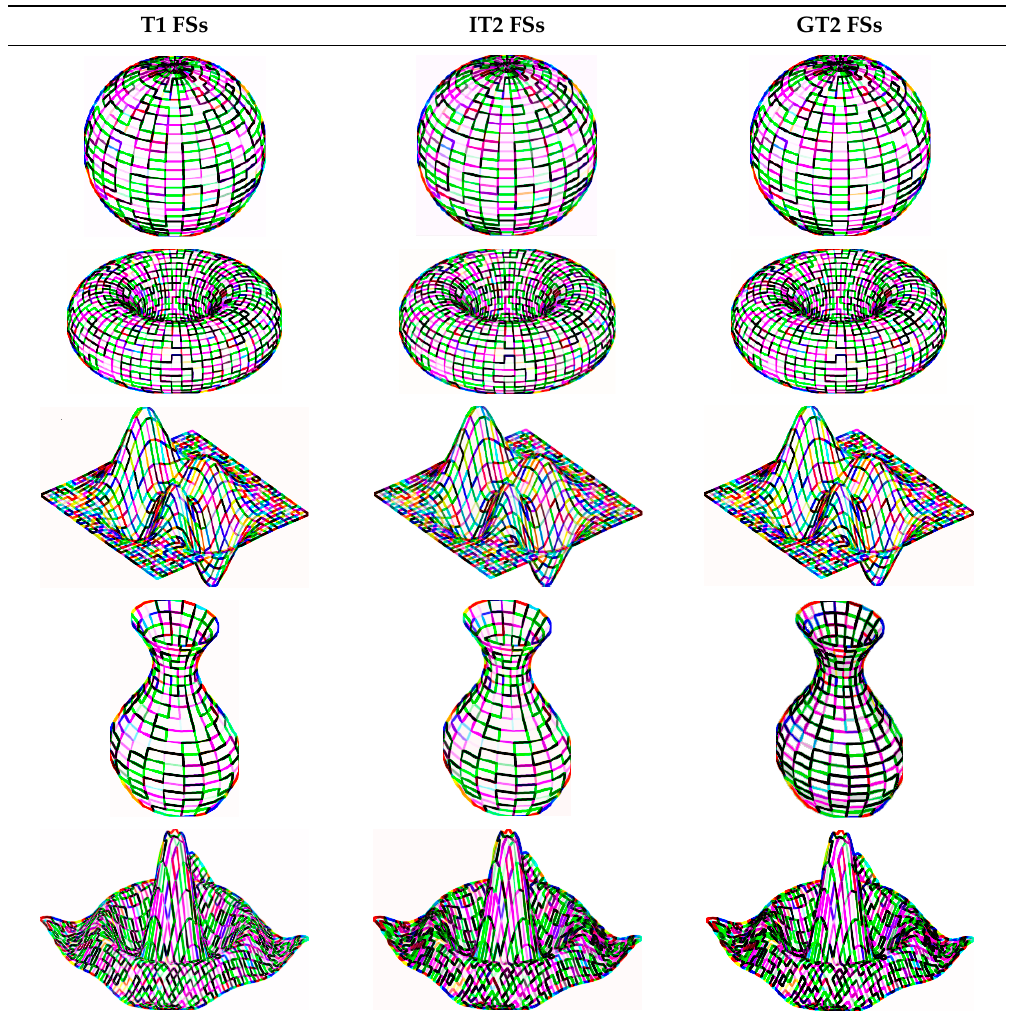
Table 13. Edge detection output using T1, IT2, and GT2 FSs.